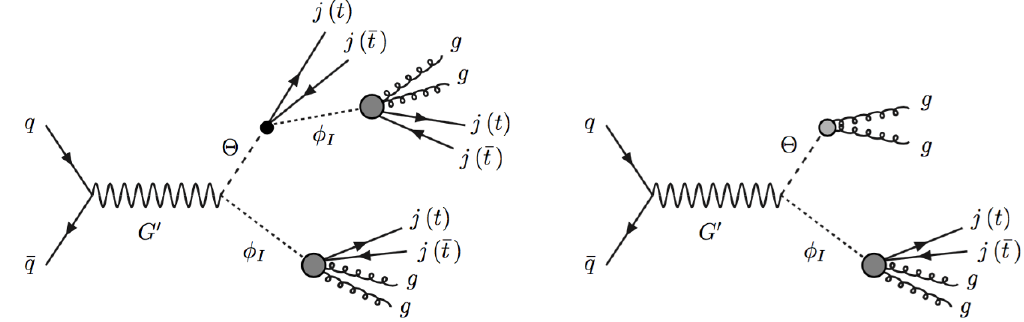
Figure 10 . Asymmetric pp G 0 (cid:30) I (cid:2) processes for M (cid:2) > M (cid:30) , when the (cid:30) I scalar decays I ! ! into two gluons plus two quarks, which occurs at one-loop (see (cid:12)gure 3). Left diagram: scalar pair production is followed by a 3-body decay of the color-octet (cid:2) into (cid:30) I plus a quark-antiquark pair, which forms two jets, or less often a t (cid:22) t pair. Right diagram: (cid:2) decays into two gluons, at one loop.